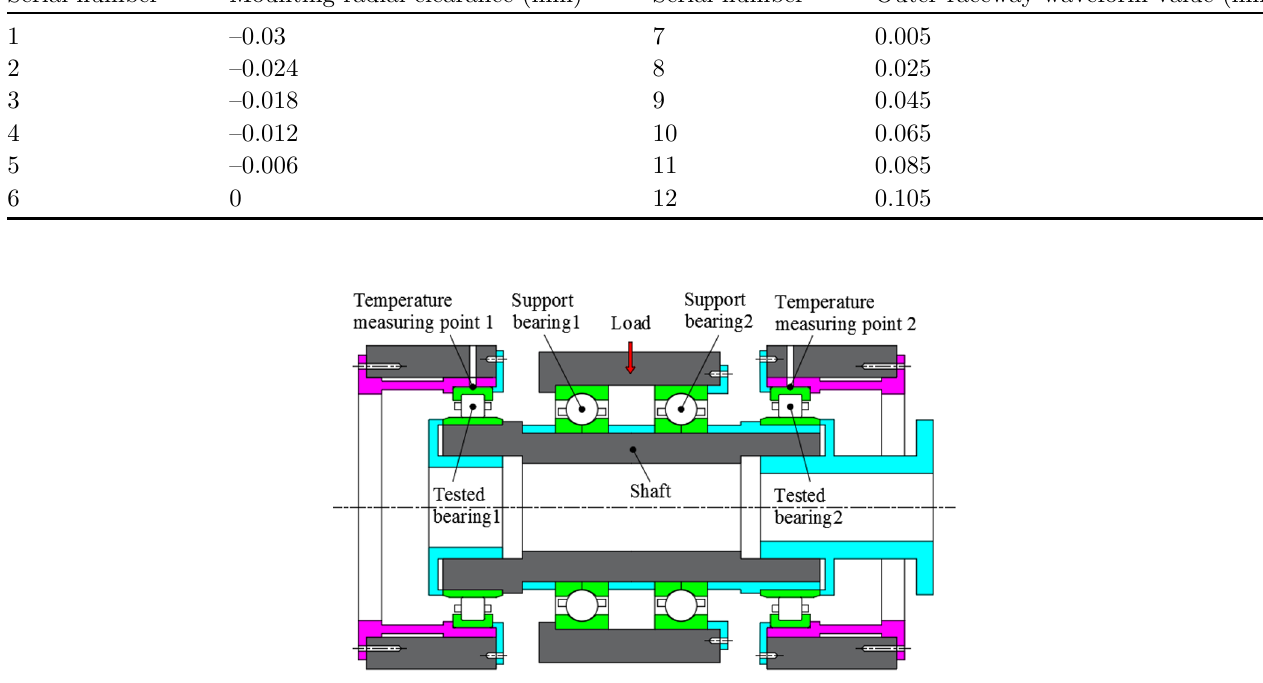
Fig. 13. Layout of the tester.